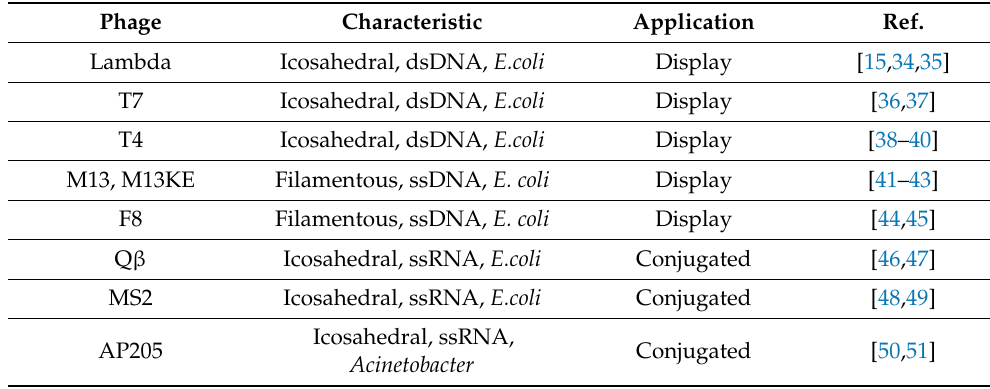
Table 1. Commonly used phages in phage-based vaccines.